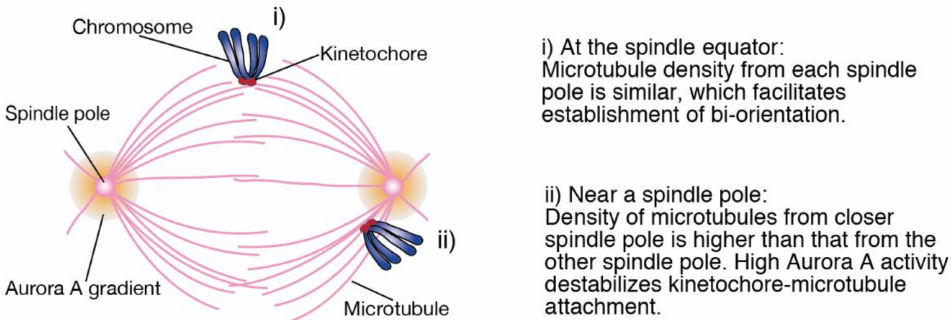
Figure 1. A schematic diagram showing the efficiency of bi-orientation establishment depending on the position of chromosomes on the spindle. Chromosomes that attach to spindle microtubules laterally at the spindle equator ( i ) and near a spindle pole ( ii ) are